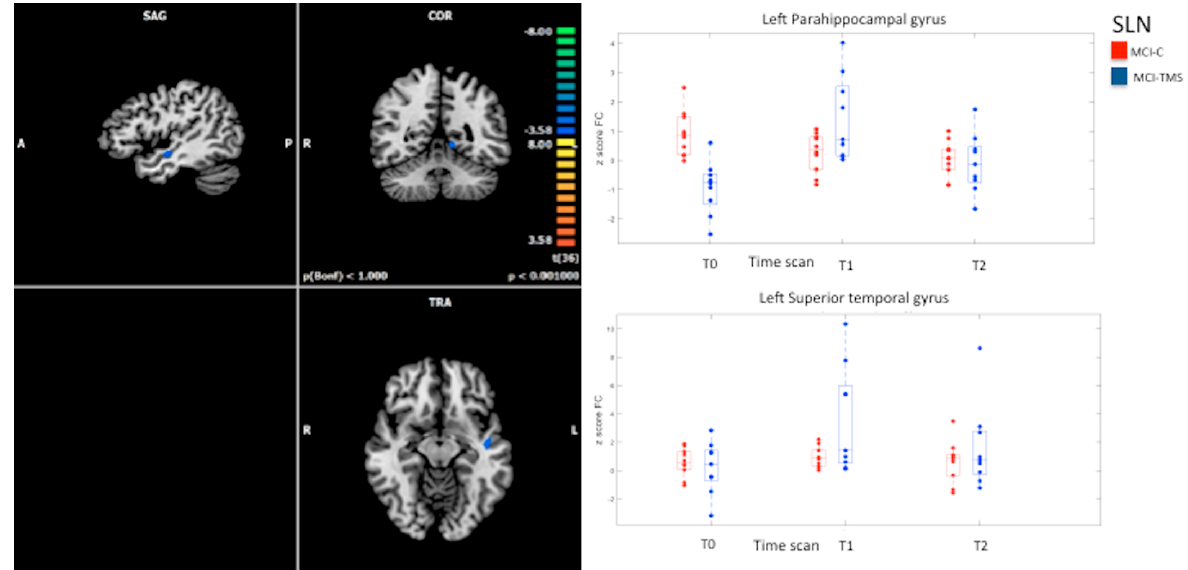
Figure 5. On the left: whole-brain significant connectivity differences between T0 MCI − TMS and T1 MCI − TMS patients ( p ≤ 0.001 cluster-level-corrected) within salience network. On the right: corresponding box-plot of the average ICA z − scores. We also reported values extracted from the MCI − C group at different time points to show a relatively constant FC in these subjects who have not undergone stimulation. No significant difference was present for other comparisons.